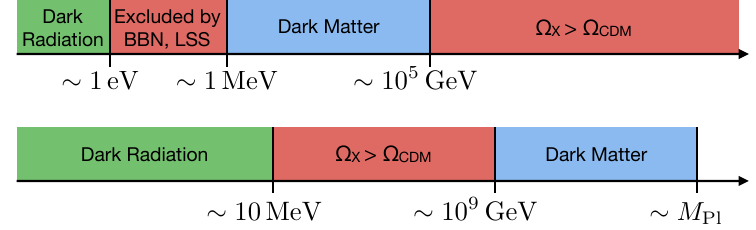
Figure 4 . In contrast to thermal relics, Hawking radiation in a black hole dominated scenario can produce dark radiation in the form of particles with masses up to m DR as well as dark matter for particles with masses between m DM the Planck scale. For thermal relics, masses below (cid:31) MeV spoil early universe cosmology [101] and masses above (cid:30) 10 5 GeV overclose the universe in perturbative, unitary theories [102].